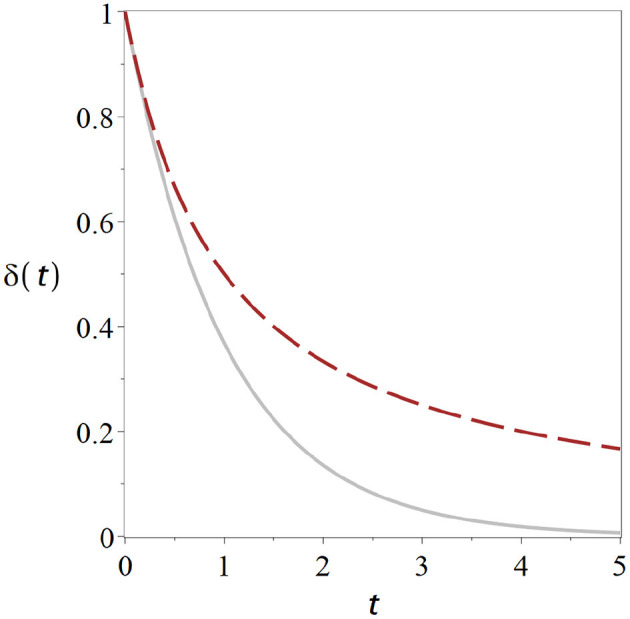
Critical states retain memory of perturbations. Curves show the return to the homeostatic state after a perturbation for a non-critical state (solid gray) and for a critical state (dashed black). The distance δ from the homeostatic level declines significantly slower for the critical state. Parameters have been chosen such that the curves start from the same initial perturbation with identical slope Exponential. Exponential return: exp (−t) (cf. Equation 9). Geometric Return: 2/(2 + 2t) (Equation 12).